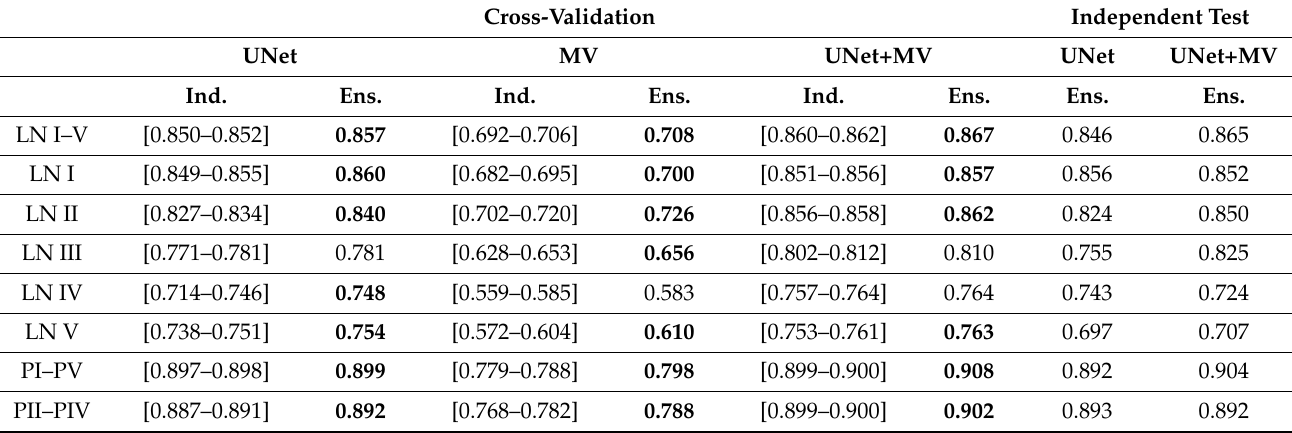
Table 1. The reported values denote the range of median DSCs produced by five individual models and ensemble model combinations of UNet, MV and UNet+MV configurations after post-processing. Ensemble results that showed higher spatial agreement than the most accurate individual model are denoted in bold. Ensembles increased result consistency and typically outperformed any of the standalone models for all configurations. Abbreviations: MV: multi-view; Ind. individual; Ens: ensemble; LN: lymph node. Cross-Validation Independent